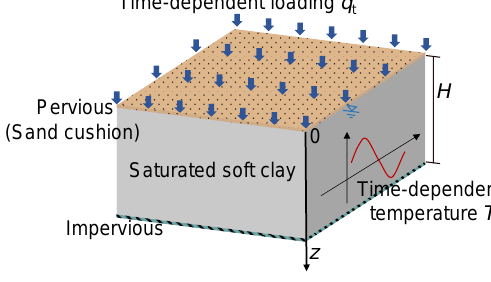
Figure 11. The strata model of saturated soft clay.